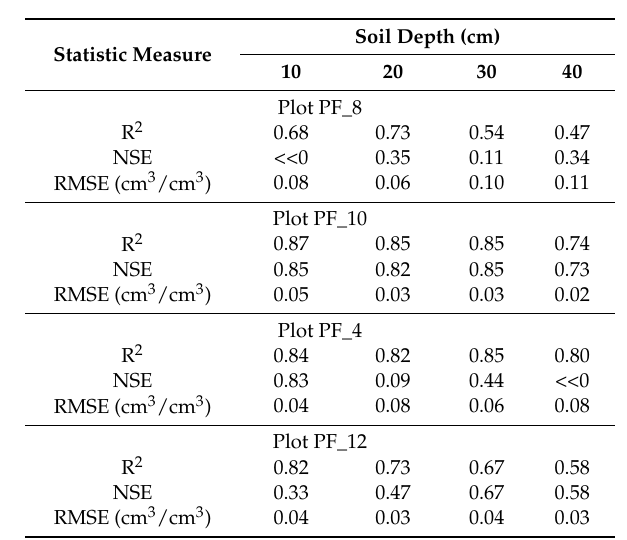
Table 6. Statistical measures of the Hydrus-1D model performance for simulations of soil moisture content at the fringe zone after calibration.